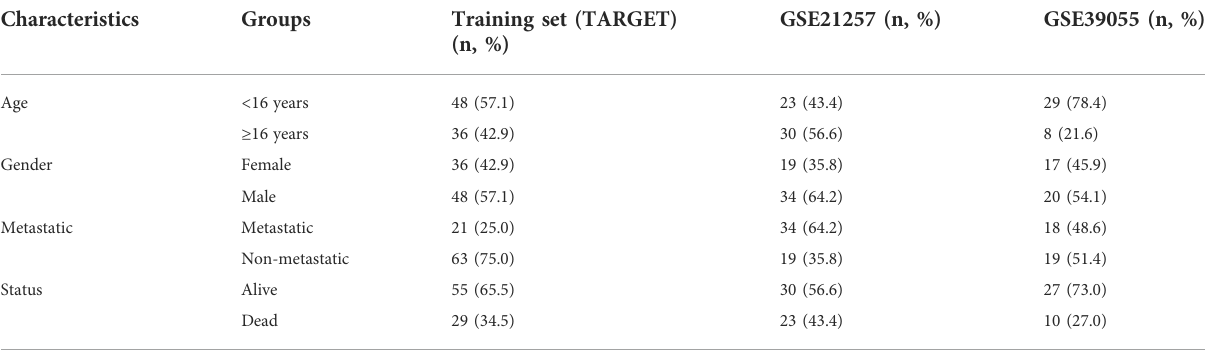
TABLE 1 Clinical characteristics for all